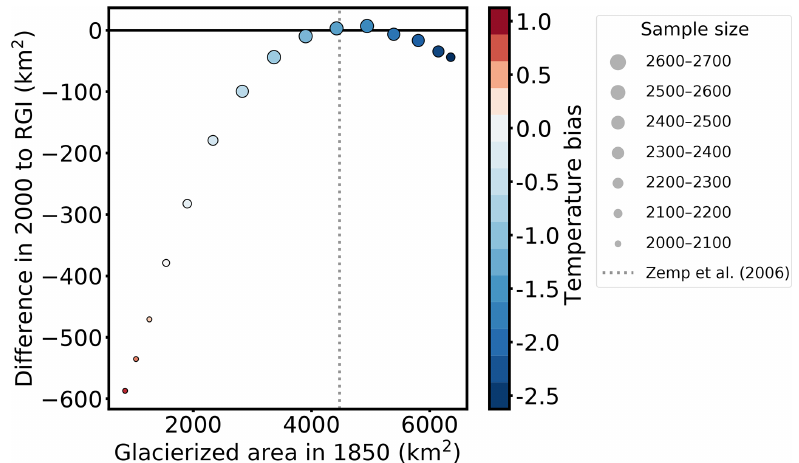
Figure A1. Difference between the total area in 2000 and the total area from the RGI plotted as a function of total area in 1850. Colors mark the applied temperature bias to create the synthetic experiments, and the size of the points mark the sample size (number of glaciers with an area larger than 0.01km 2 in 2000). The dashed grey line marks the estimated total area of all Alpine glaciers in 1850 from Zemp et al.